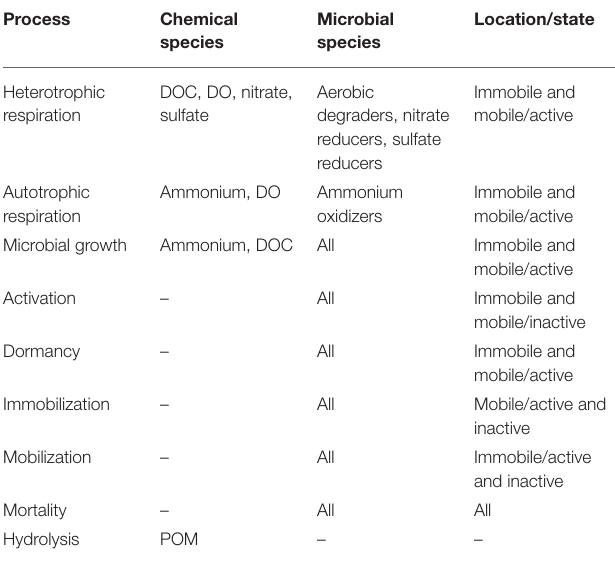
TABLE 1 | Summary of process network: components, acting microbial species, and